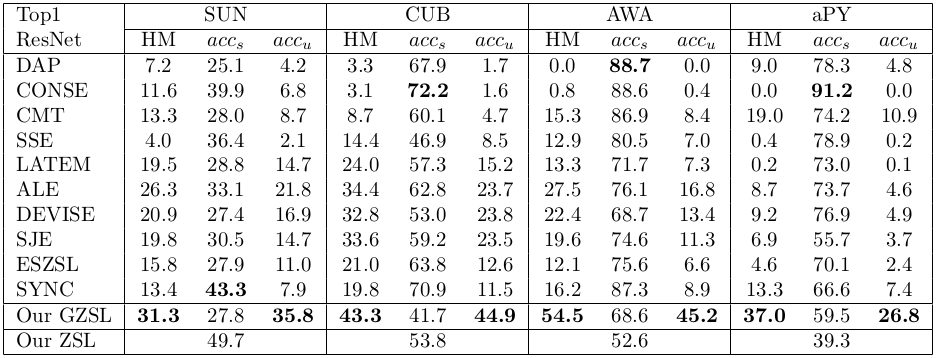
Table from the paper: A Unified approach for Conventional Zero-shot, Generalized Zero-shot and Few-shot Learning
Table text:
Top1
SUN
CUB
AWA
aPY
ResNet
HM
acc s
acc u
HM
acc s
acc u
HM
acc s
acc u
HM
acc s
acc u
DAP
7.2
25.1
4.2
3.3
67.9
1.7
0.0
88.7
0.0
9.0
78.3
4.8
CONSE
11.6
39.9
6.8
3.1
72.2
1.6
0.8
88.6
0.4
0.0
91.2
0.0
CMT
13.3
28.0
8.7
8.7
60.1
4.7
15.3
86.9
8.4
19.0
74.2
10.9
SSE
4.0
36.4
2.1
14.4
46.9
8.5
12.9
80.5
7.0
0.4
78.9
0.2
LATEM
19.5
28.8
14.7
24.0
57.3
15.2
13.3
71.7
7.3
0.2
73.0
0.1
ALE
26.3
33.1
21.8
34.4
62.8
23.7
27.5
76.1
16.8
8.7
73.7
4.6
DEVISE
20.9
27.4
16.9
32.8
53.0
23.8
22.4
68.7
13.4
9.2
76.9
4.9
SJE
19.8
30.5
14.7
33.6
59.2
23.5
19.6
74.6
11.3
6.9
55.7
3.7
ESZSL
15.8
27.9
11.0
21.0
63.8
12.6
12.1
75.6
6.6
4.6
70.1
2.4
SYNC
13.4
43.3
7.9
19.8
70.9
11.5
16.2
87.3
8.9
13.3
66.6
7.4
OurGZSL
31.3
27.8
35.8
43.3
41.7
44.9
54.5
68.6
45.2
37.0
59.5
26.8
OurZSL
49.7
53.8
52.6
39.3